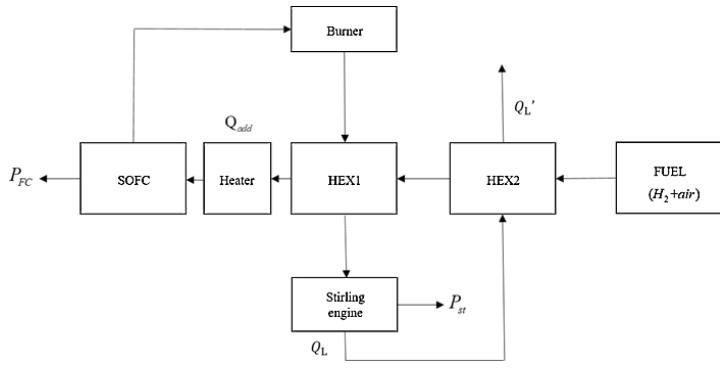
Figure 9. System loop of the hybrid SOFC-SE after optimized design.